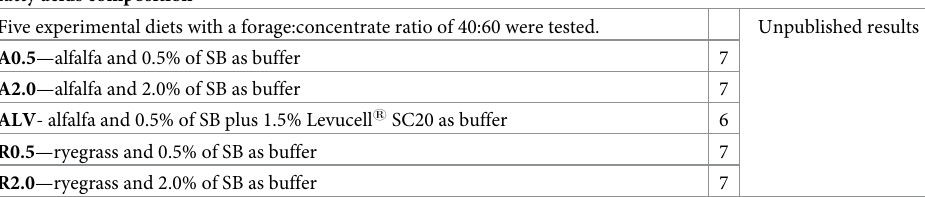
3—Effects of the forage source and the proportion and type of dietary rumen buffer on rumen and lamb meat fatty acids composition Five experimental diets with a forage:concentrate ratio of 40:60 were